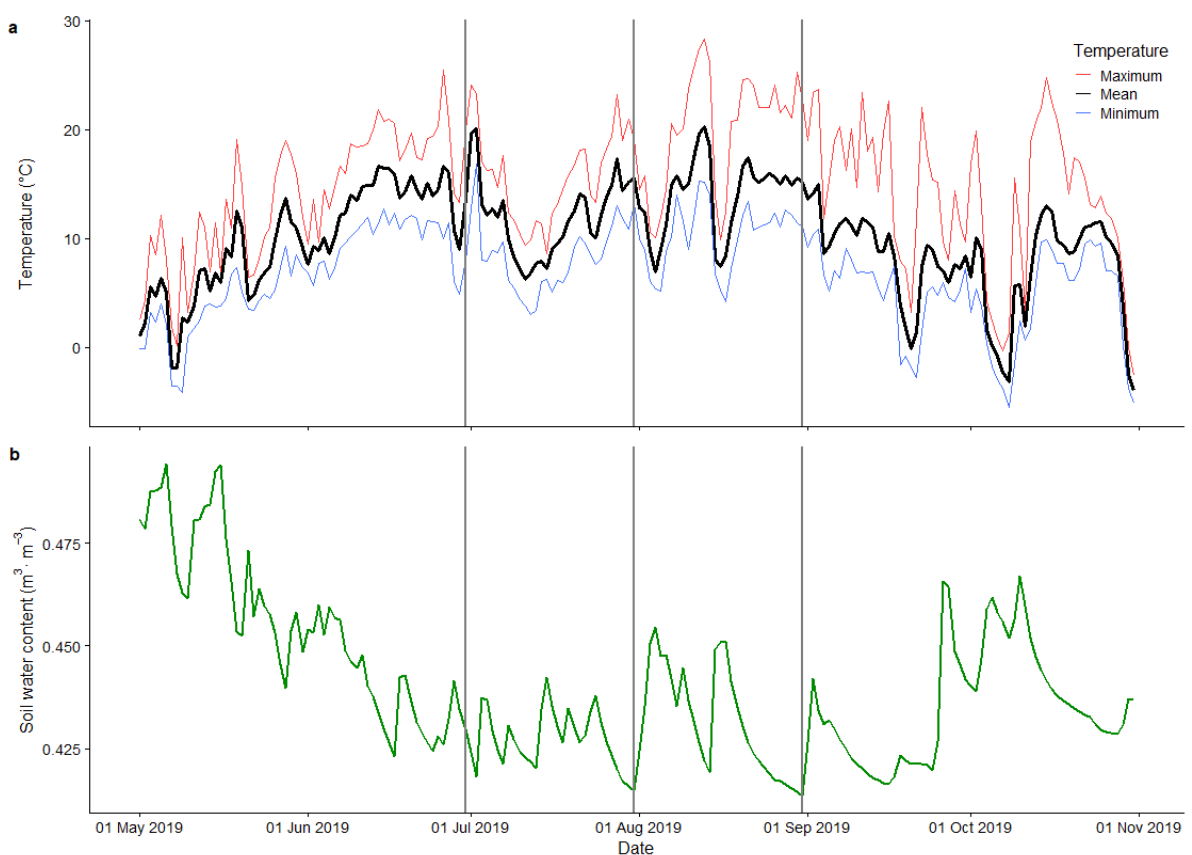
Figure 1. Air temperature ( a ) and soil water content ( b ) variation during the 2019 growing season (vertical lines represent measurements dates).